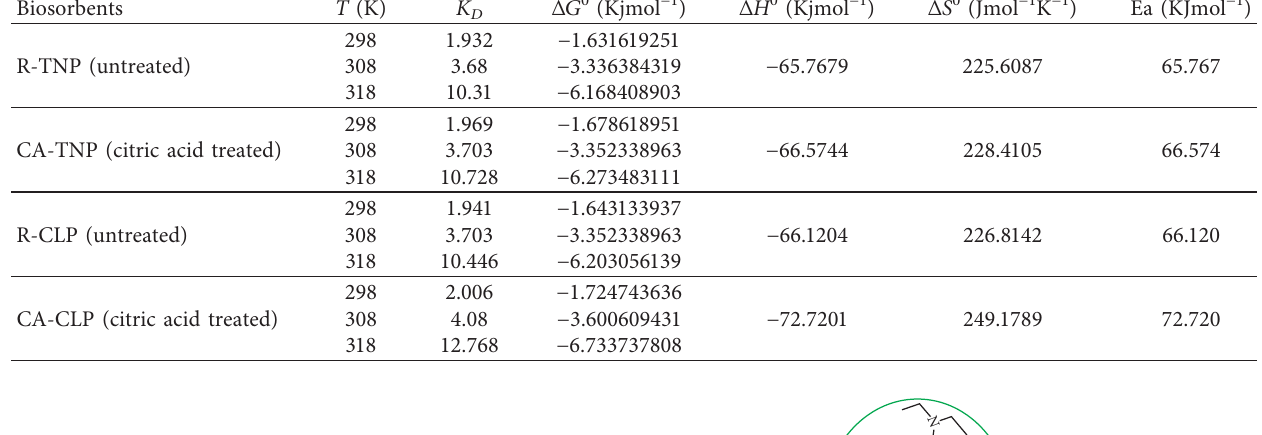
Table 5: Thermodynamic parameters for BGD adsorption.